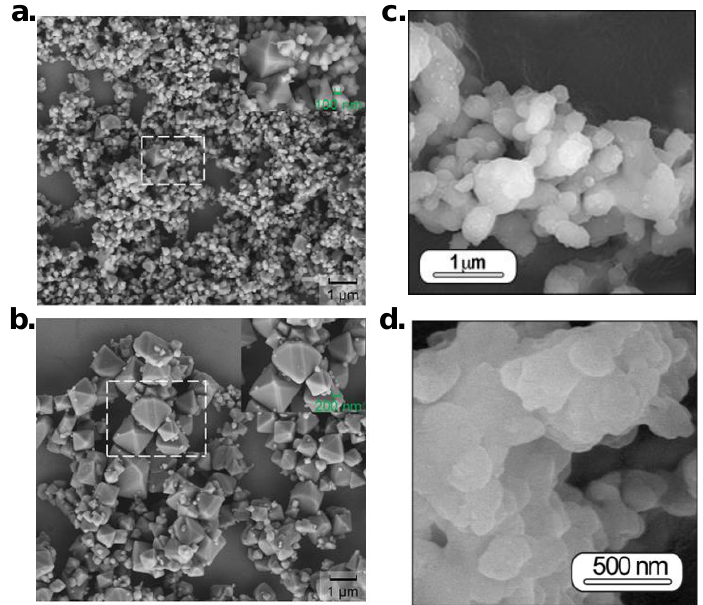
Figure 1. SEM micrographs of MgAl 2 O 4 :Mn phosphors heated at 950 °C for 6 h in 90N 2 -10H 2 atmosphere using ( a ) nano α -Al 2 O 3 and ( b ) nano γ -Al 2 O 3 . Reprinted with permission from [30]. Copyright 2020, American Chemical Society Publishing . FE-SEM micrographs of powders based on SrAl 2 O 4 :Eu, Dy heated at 1000 °C for 2 h in 90N 2 -10H 2 atmosphere, employing a salt/SrAl 2 O 4 molar ratio of 3:1 using ( c ) nano α-Al 2 O 3 and ( d ) nano γ-Al 2 O 3.